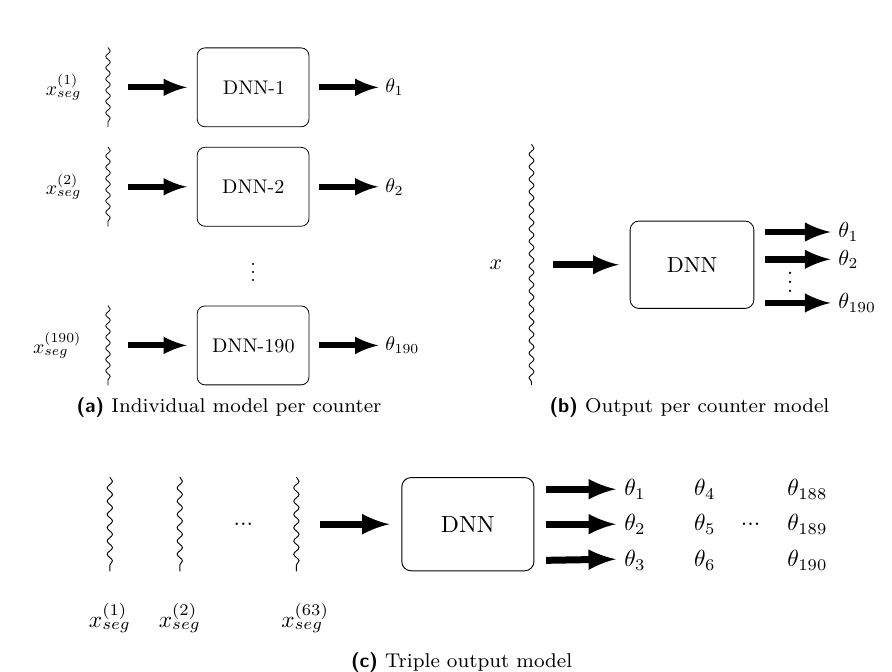
Figure 6: Approaches to attack the ZU+ encryption engine. In the model-per-counter setting (a), the traces are split up in several segments x representing the leakages of a seg single counter value. For each counter, an individual DNN is created to produce optimized encodings θ . The output-per-counter model (b) is fed with complete traces and outputs all encodings in a single pass. Furthermore, the triple-output-model (c) receives trace segments corresponding to three counter leakages and outputs the respective